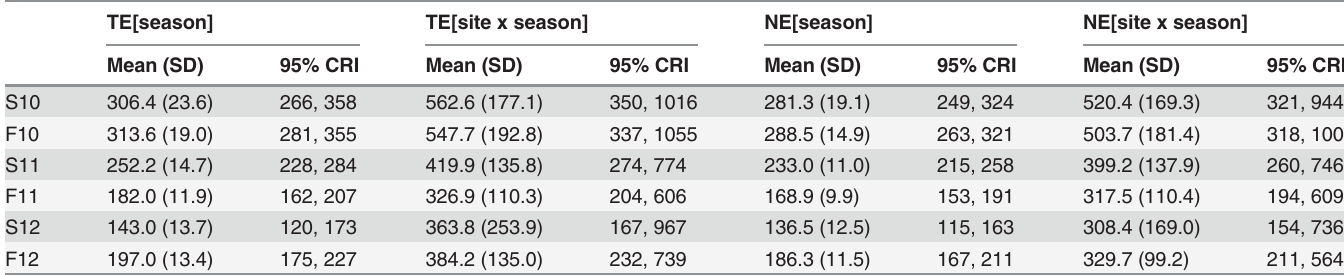
Table 1. Per-season estimates of P . serratus abundance over 40 9-m 2 plots.